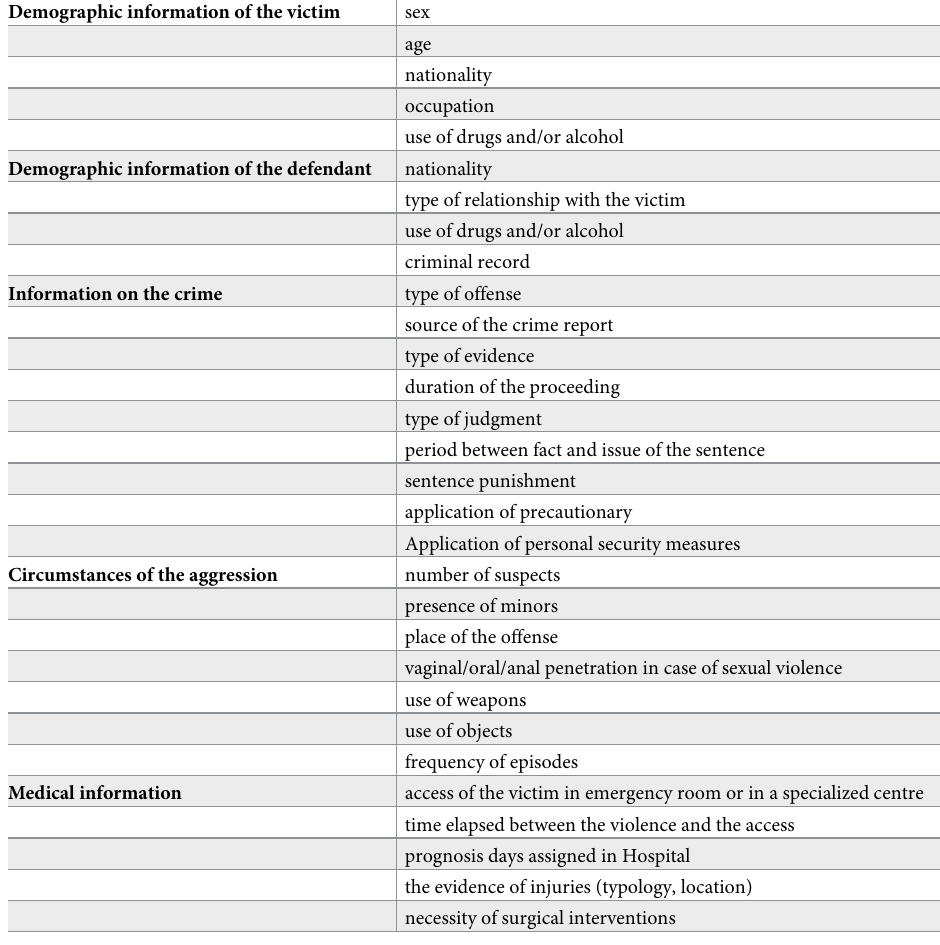
Table 1. Information extrapolated from